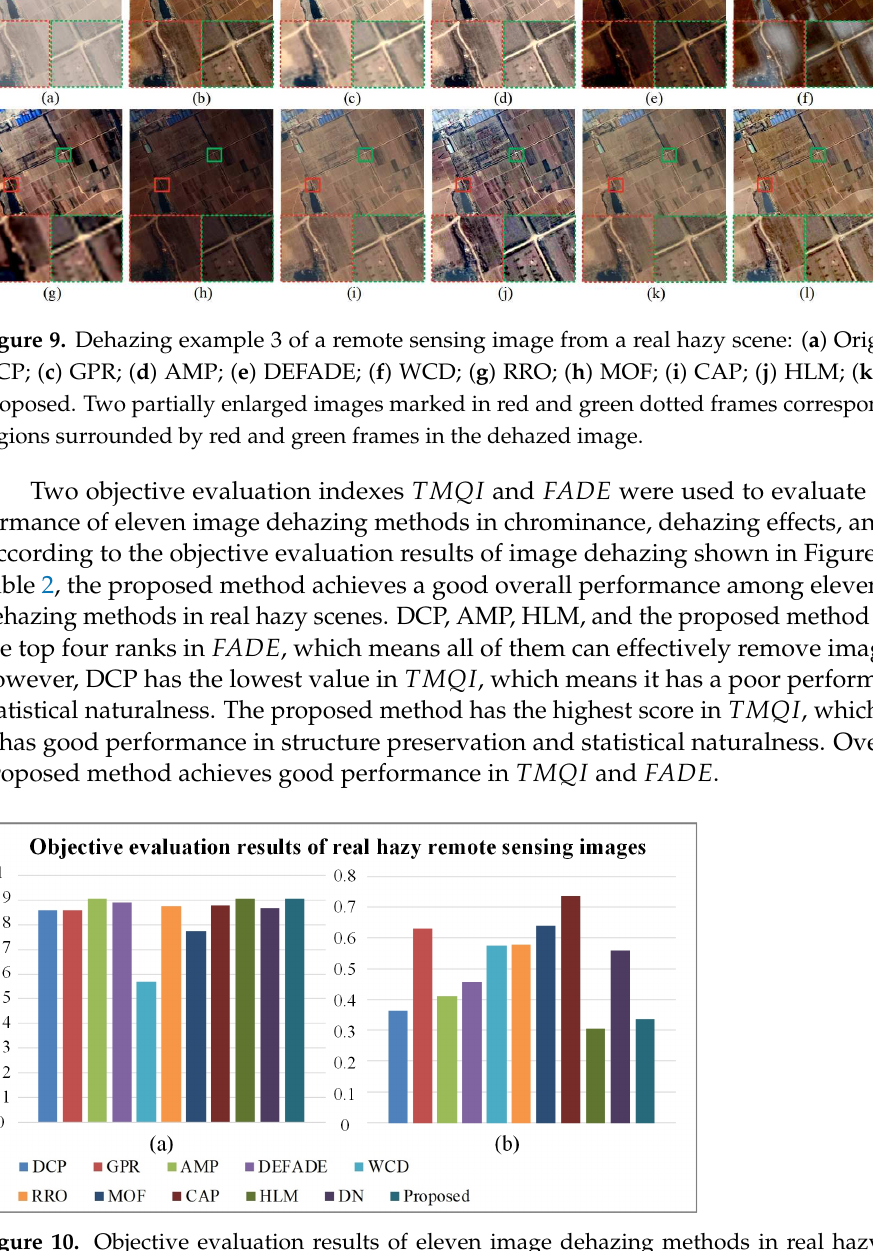
Figure 10. Objective evaluation results of eleven image dehazing methods in real hazy scenes: ( a ) TMQI ; ( b ) FADE . The higher value of the TMQI index is better, the lower value of the FADE index is